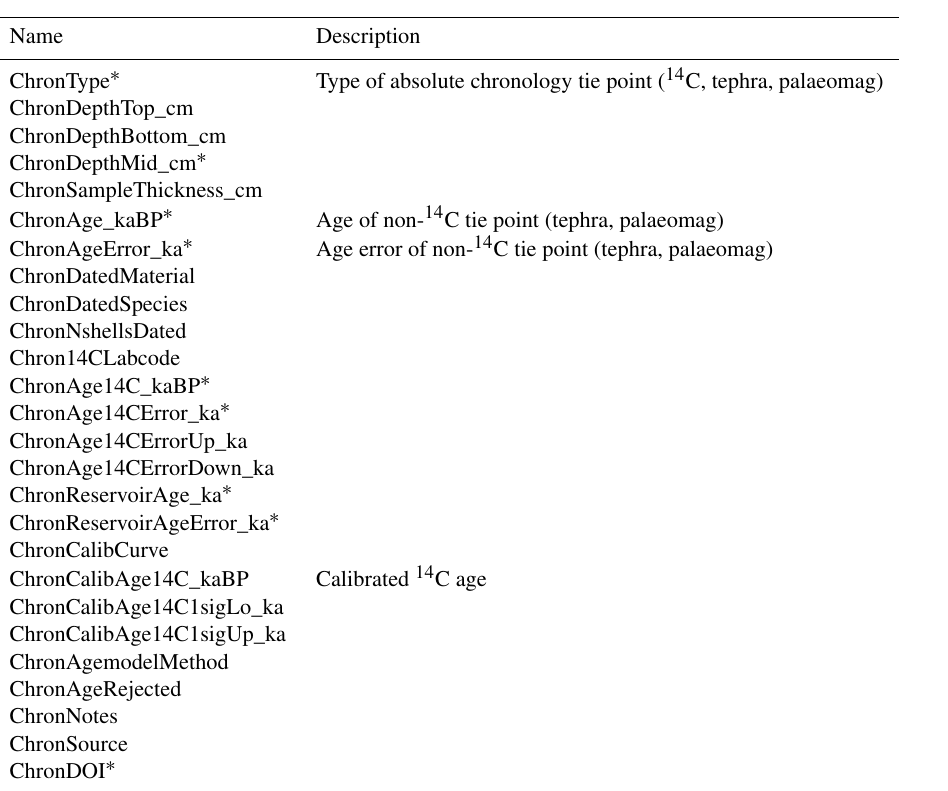
Table 4. Chronology